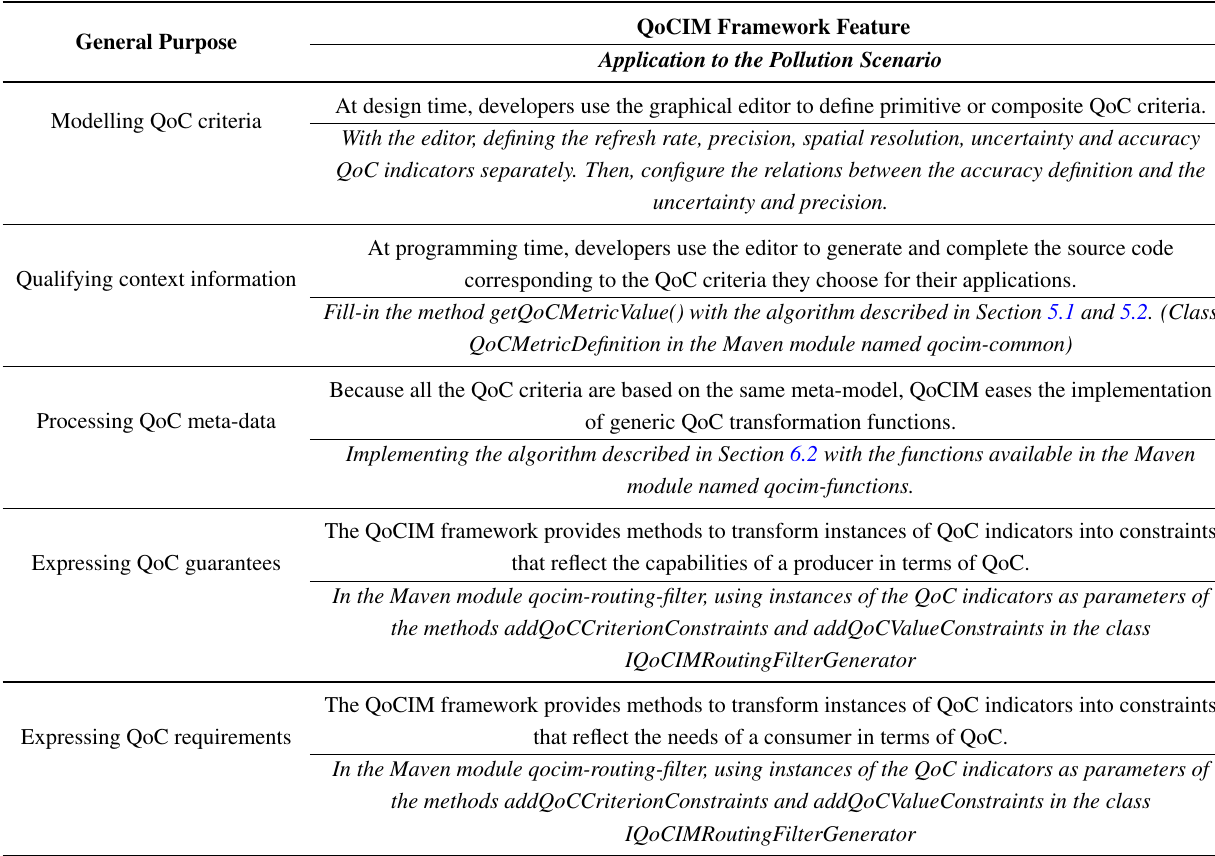
Table 5. The benefits of the QoCIM framework within a Distributed Context